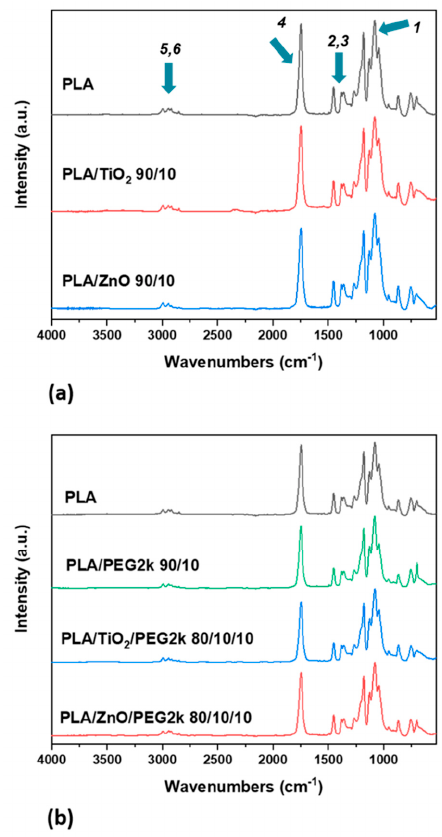
Figure 3. FTIR spectra of PLA ( a ) with 10 wt% ceramic fillers and ( b ) with 10 wt% PEG. The arrows correspond to peaks that are detailed in Table 2 below. Table 2. FTIR peaks associated with the spectra of PLA in Figure 3.